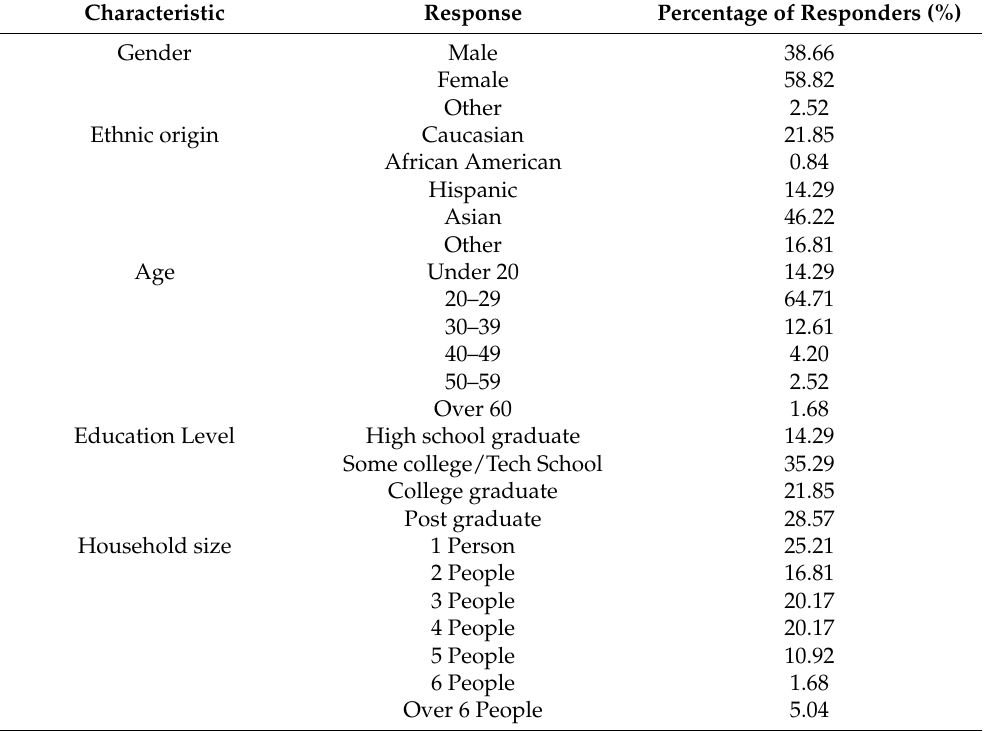
Table A1. Demographic data of consumers ( n = 120) that participated in tasting panel evaluation of steaks from cattle under different feeding systems 1